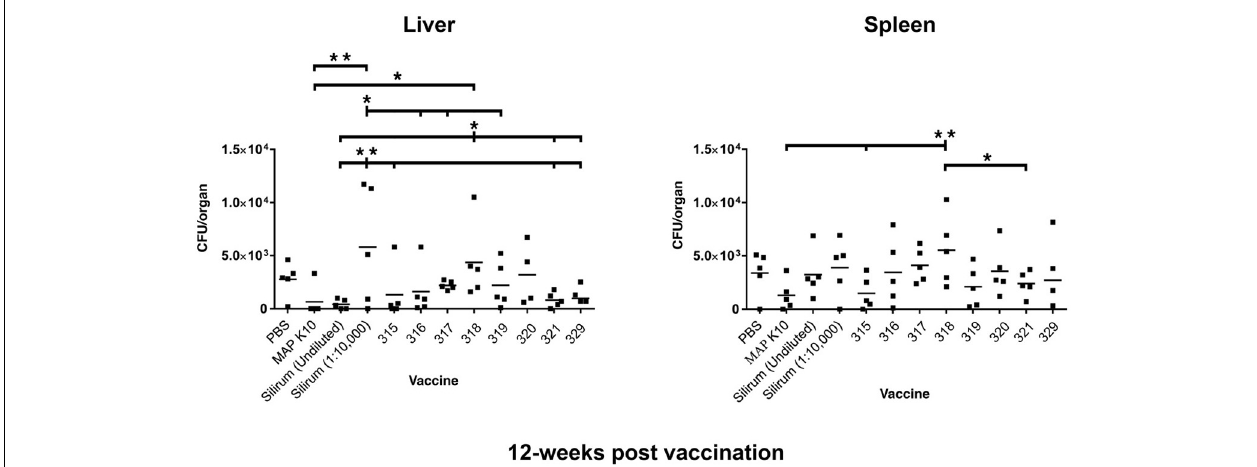
FIGURE 2 | MAP burden in liver and spleen at 12 weeks post vaccination. A single asterisk denotes statistical significance at P < 0 . 05 and two asterisks show statistical significance at P < 0 . 01. The bar in each treatment represents the average of five mice.